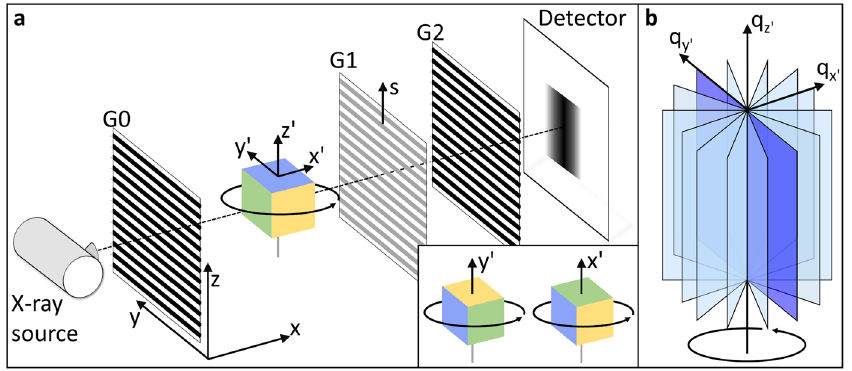
Figure 1. Talbot-Lau X-ray grating interferometer with horizontal gratings. ( a ) Schematic set-up of a three- grating interferometer including a source grating G0, a phase-grating G1 and an analyzer grating G2. During a tomographic measurement the samples coordinate system (x’, y’, z’) is rotated with respect to the laboratory coordinate system (x, y, z). The sensitivity direction of the grating interferometer is given by s . ( b ) For each sample orientation, the dark-field signal probes a specific two-dimensional slice of the three-dimensional reciprocal space used to describe small-angle scattering. The signal in the scattering direction parallel to the rotation axis, z’ in this case, is rotationally invariant. Inset: A rotation of the sample can be used to align different scattering directions parallel to the rotation